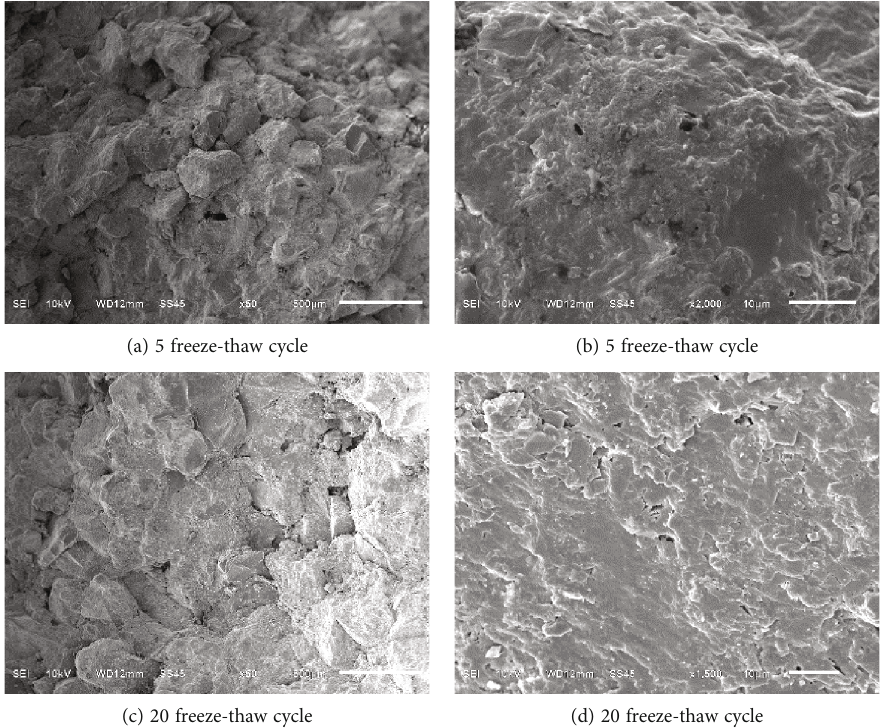
Figure 10: SEM images of cyan sandstone at 50 and 2000 times under di ff erent number of freeze-thaw